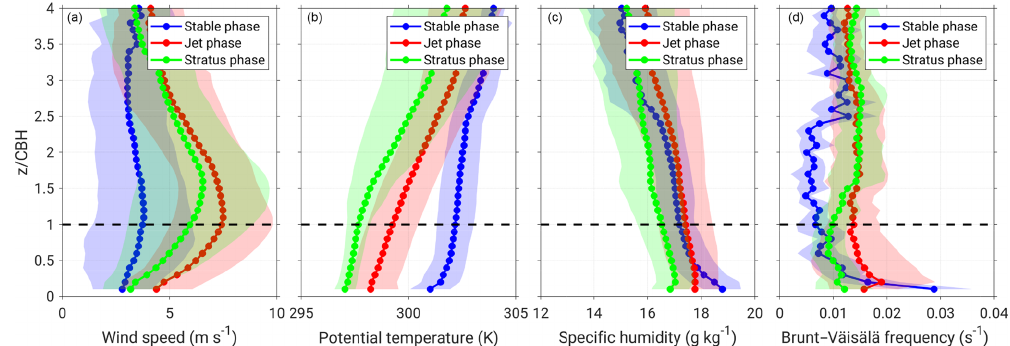
Figure 7. Mean profiles of horizontal wind speed (a) , potential temperature (b) , specific humidity (c) and Brunt–Väisälä frequency (d) averaged for the stable phase, jet phase and stratus phase. The shading indicates the standard deviation. The number of profiles used for the averaging are 6 for the stable phase, 37 for the jet phase and 52 for the stratus phase. Before averaging, the profiles are normalized with the median CBH for each IOP.